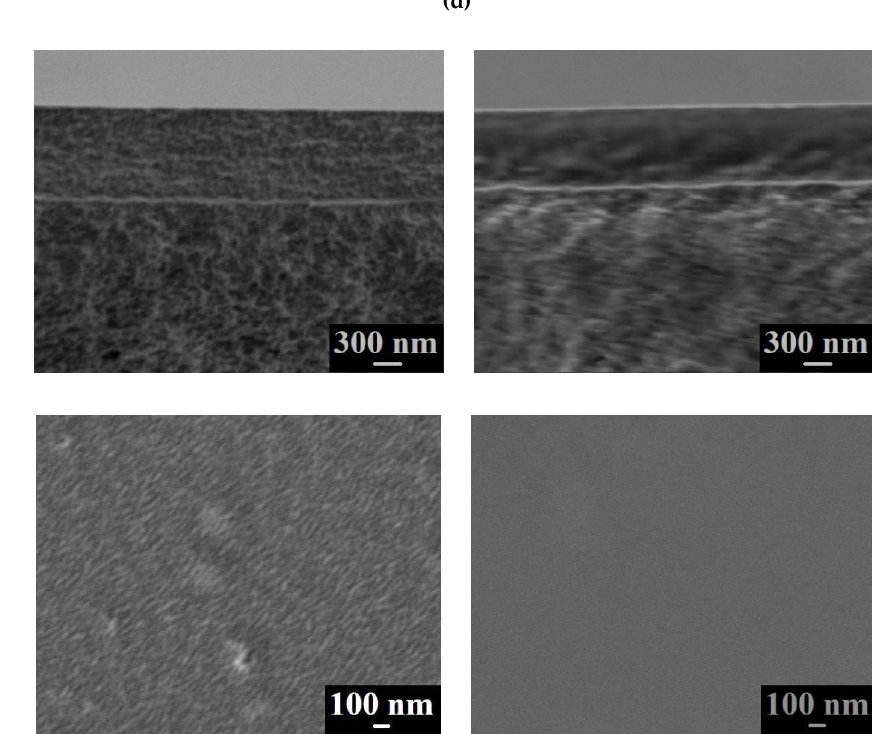
Figure 8. SEM cross-sectional and surface micrographs of the TFC membranes ( a ) CS / PAN-2, ( b ) CS / PAN-3, ( c ) CS / PAN-4, ( d ) CS / PAN-5 with and without polyamide layer formed by IP.